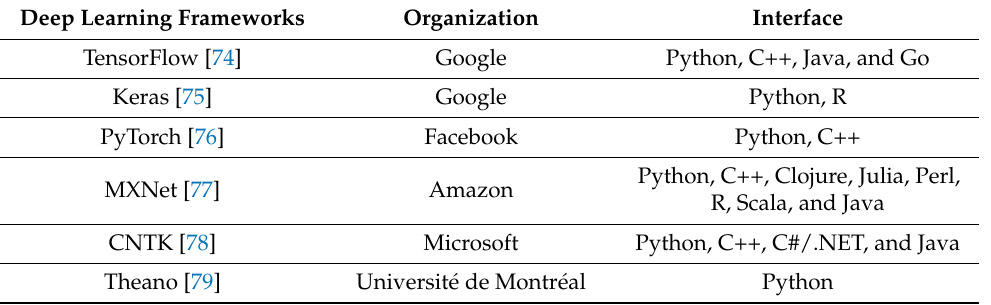
Table 6. Summary of deep learning